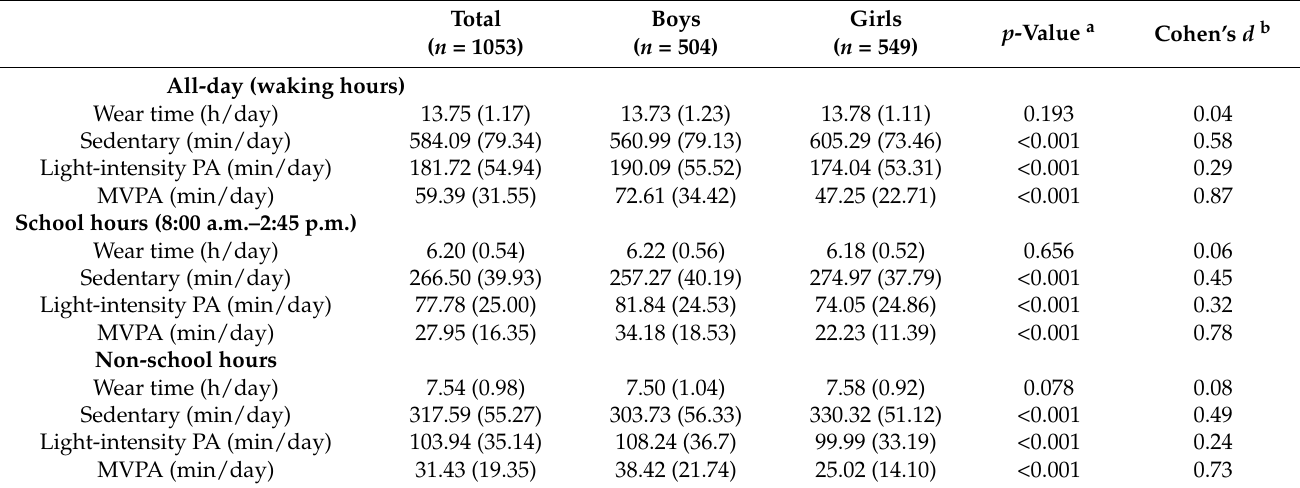
Table 2. The Objectively Measured Physical Activity Levels in Omani Children During School Days.